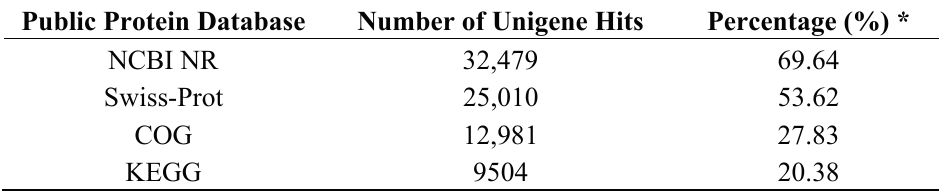
Table 2. Hit percentages against important public